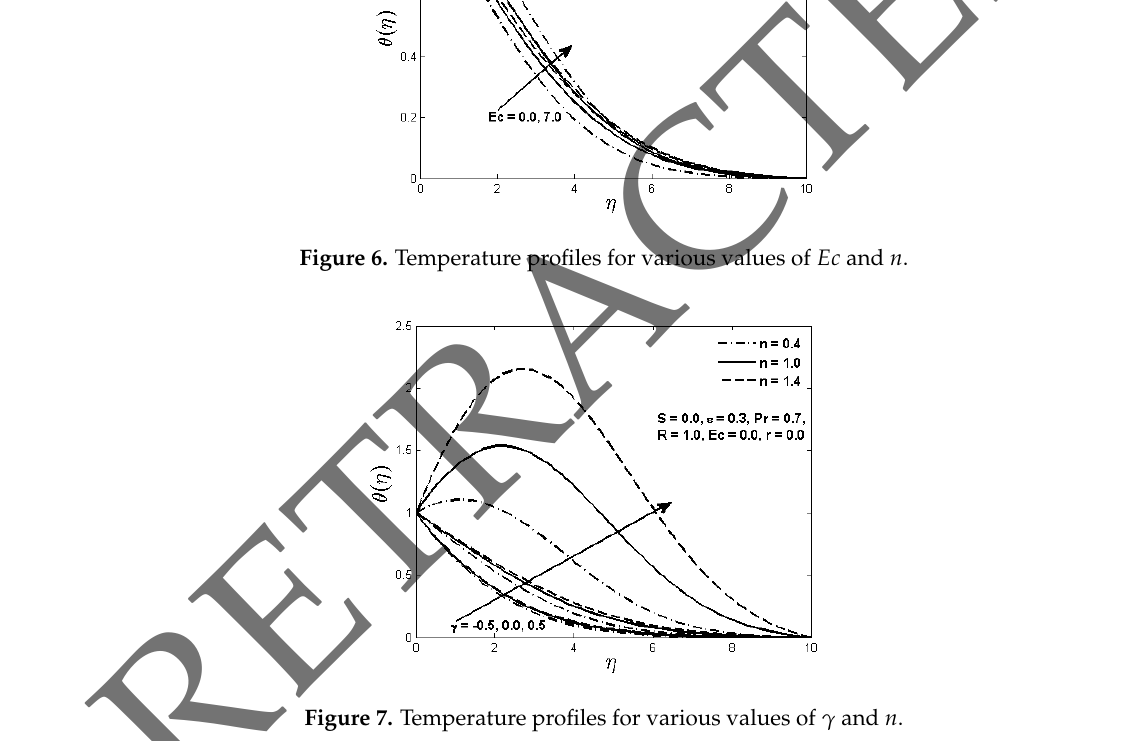
Figure 7. Temperature profiles for various values of γ and n .